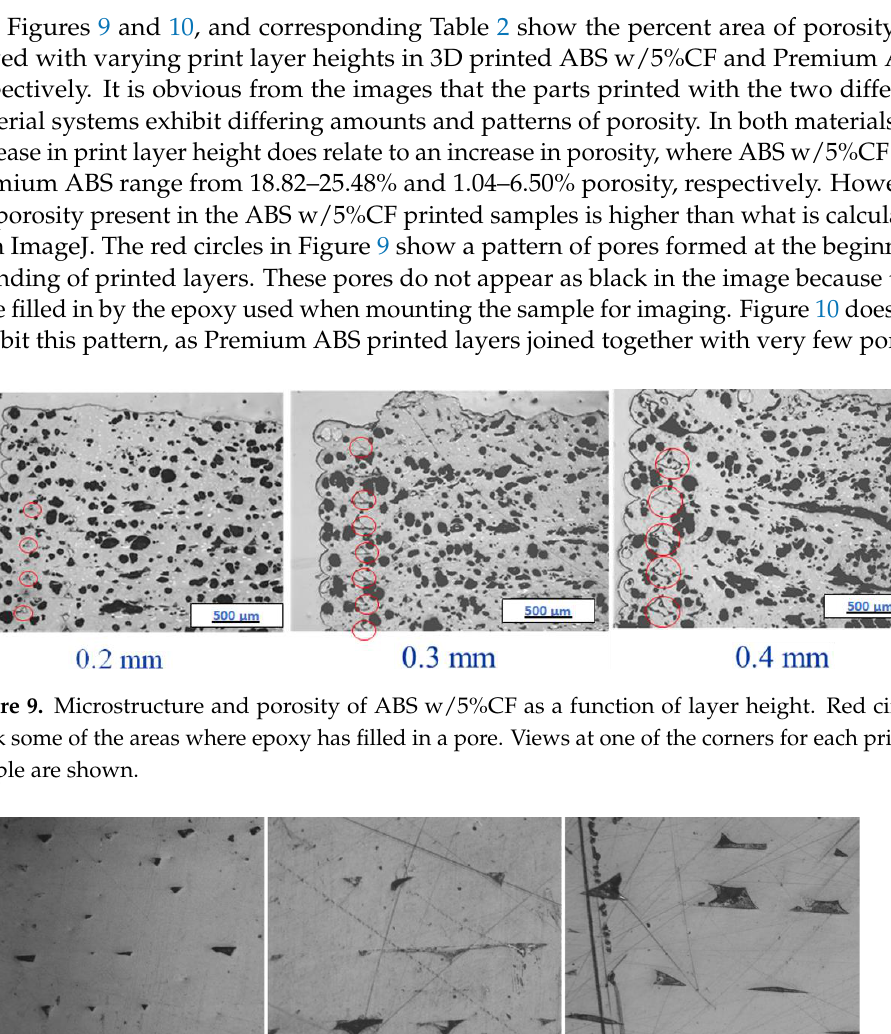
Figure 8. ImageJ analysis done on ( a ) porosity identified as large pores and holes left from removed chopped fibers, and ( b ) porosity identified only as large pores in ABS w/5%CF.